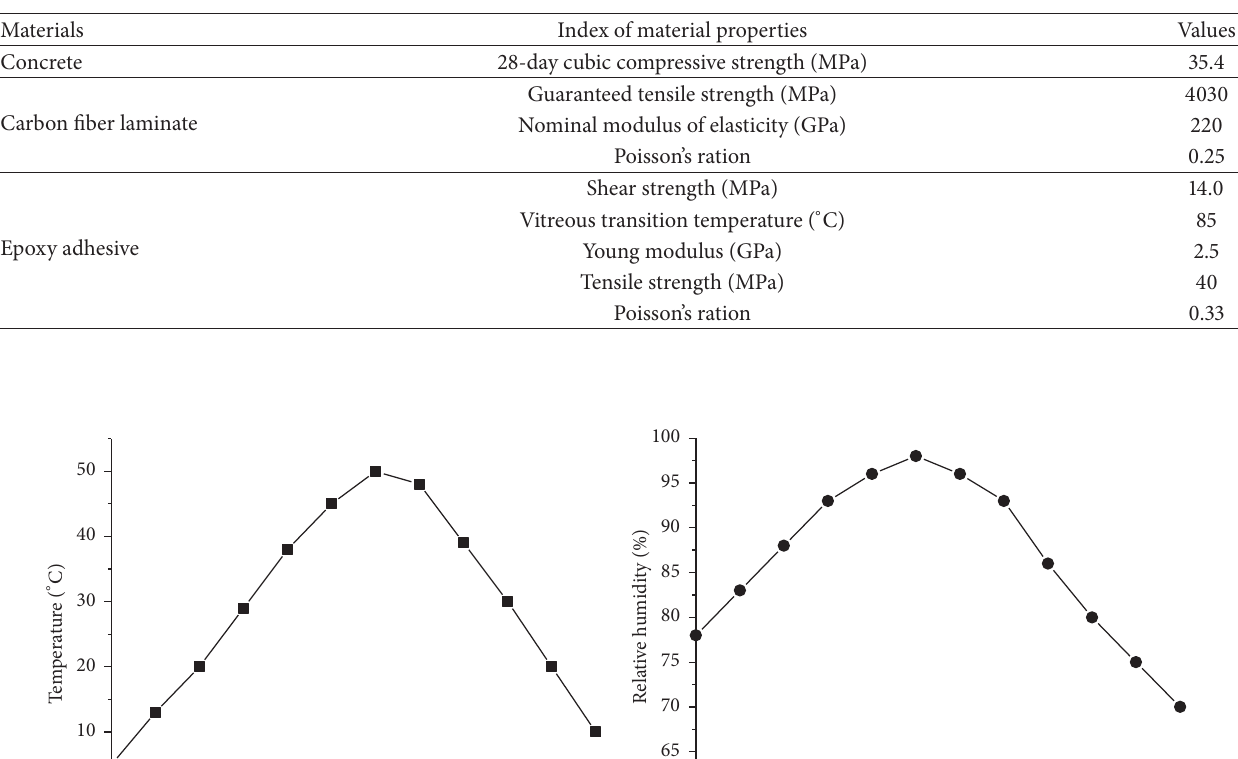
Table 1: Summary of material properties.